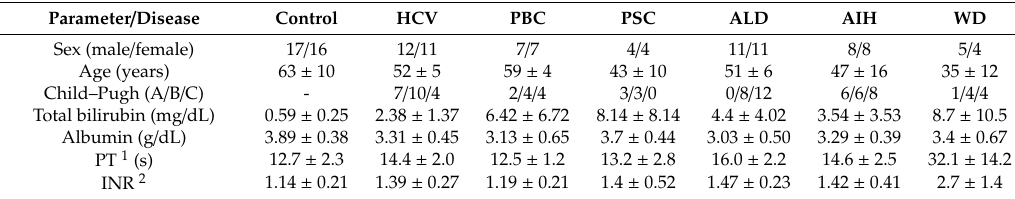
Table 1. Characteristics of subjects. Patient cohorts are hepatitis C (HCV, n = 23), primary biliary cholangitis (PBC, n = 14), primary sclerosing cholangitis (PSC, n = 8), alcoholic liver disease (ALD, n = 22), Wilson’s disease (WD, n = 9), and autoimmune hepatitis (AIH, n = 16). Other information include the stage of cirrhosis progression according to the Child–Pugh score (CPS), total bilirubin, albumin, prothrombin time, and international normalized